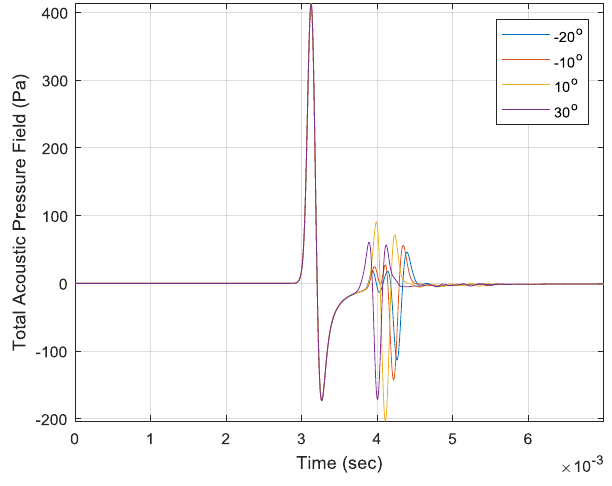
Figure 7. The received acoustic pressure field for various AoAs.